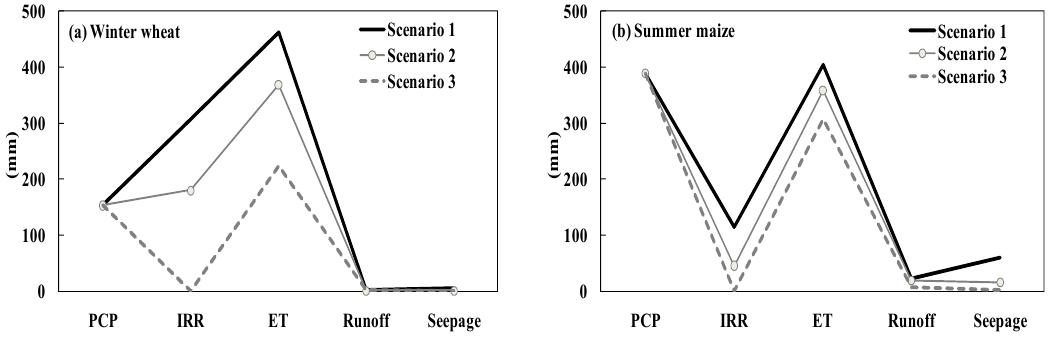
Figure 7. Comparison of precipitation (PCP), irrigation (IRR), ET, runoff, and seepage during winter wheat and summer maize growing seasons under different scenarios. ( a ) Winter wheat season; and ( b ) summer maize season.